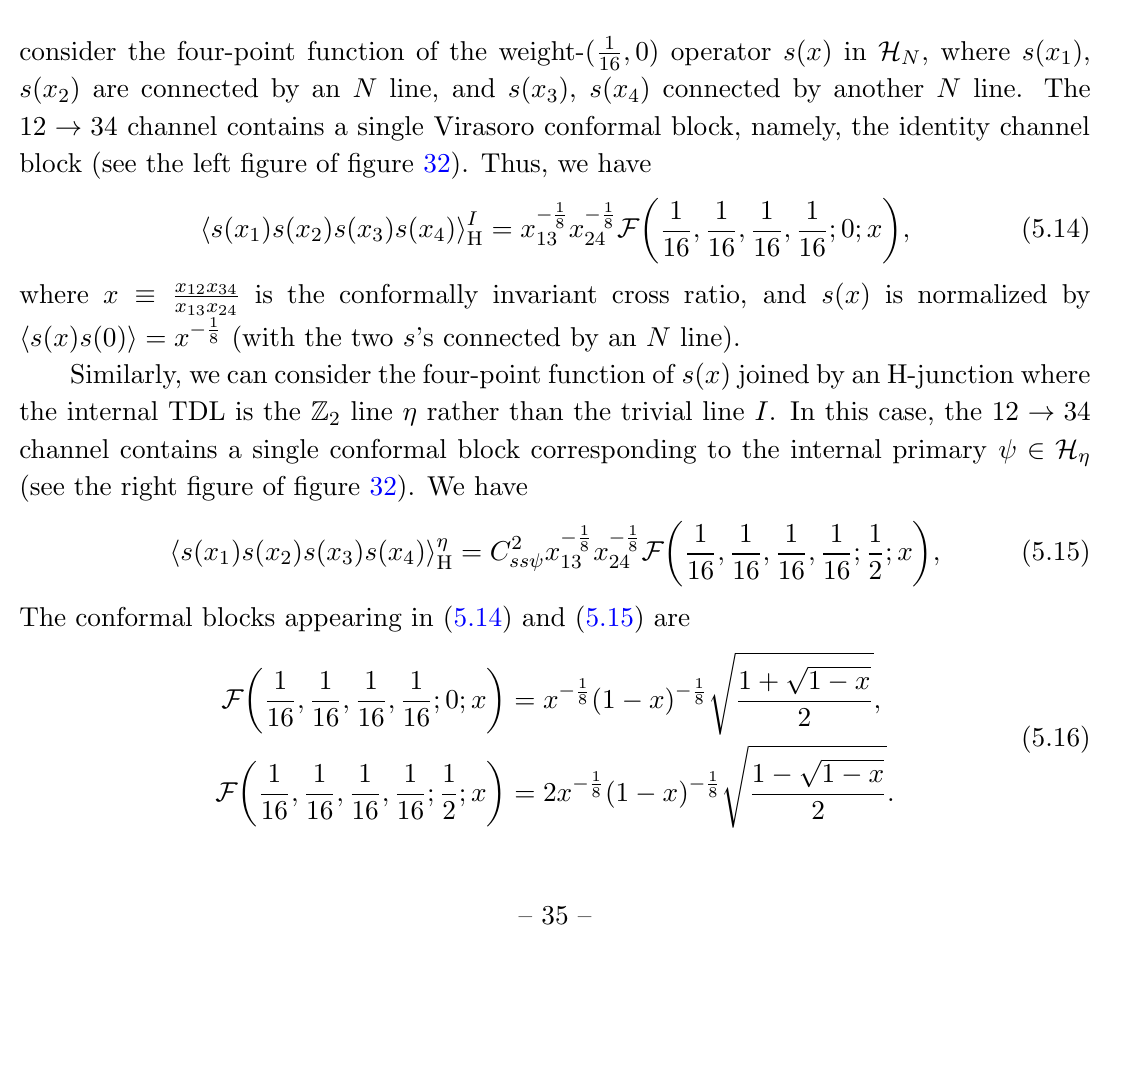
Figure 32 . The four-point functions of s ( x ) joined by H-junctions, h s ( x 1 ) s ( x 2 ) s ( x 3 ) s ( x 4 ) i I h s ( x 1 ) s ( x 2 ) s ( x 3 ) s ( x 4 ) i (cid:17) H